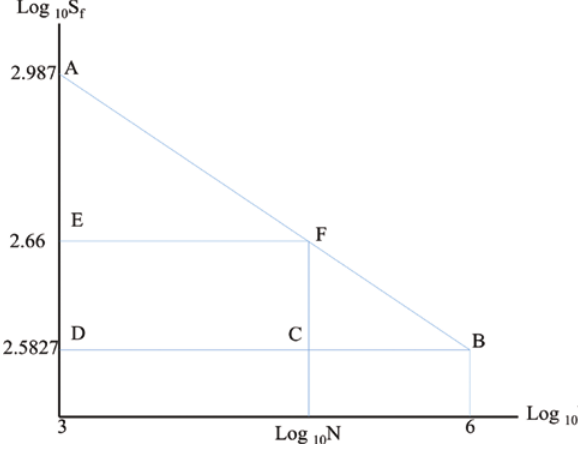
Figure 3: S–N curve on a log–log graph